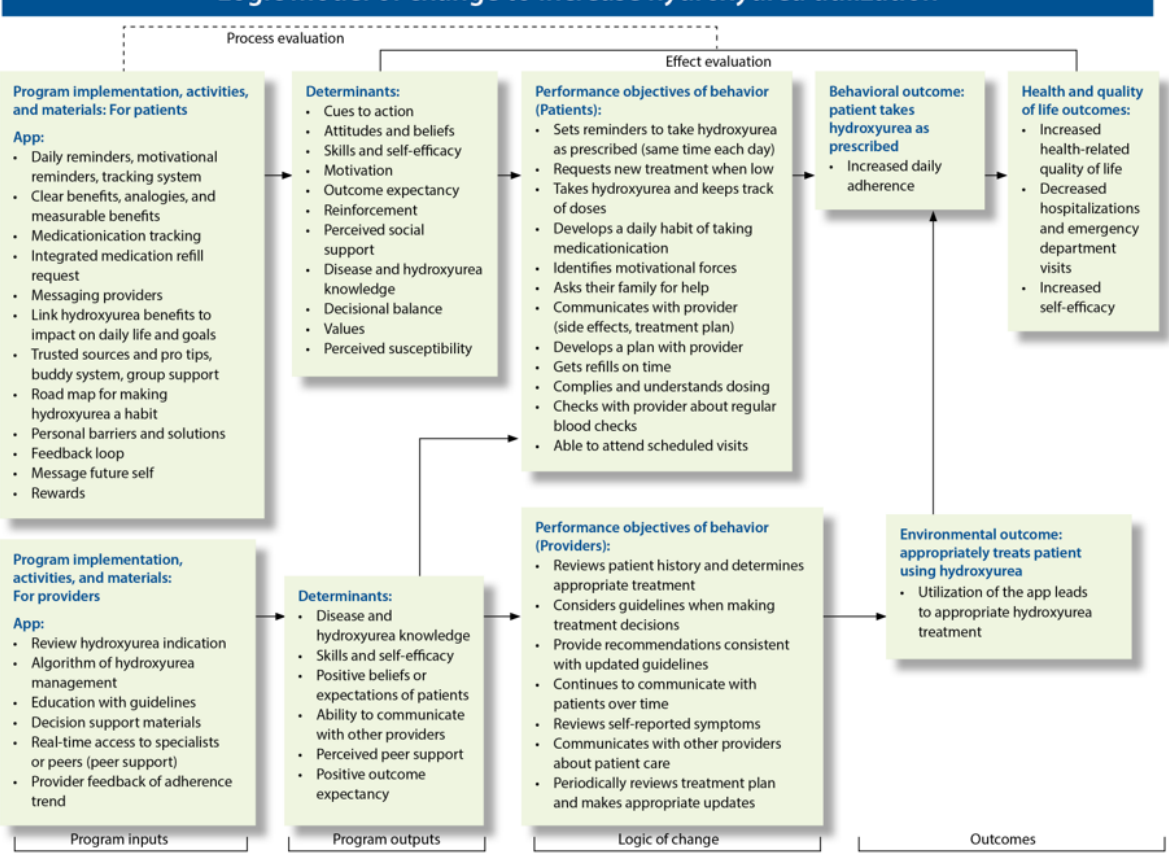
Figure 1. Logic model of change to increase hydroxyurea utilization. This logic model maps all barriers identified by literature review and needs assessment analysis, with a focus on the determinants of the behaviors to hydroxyurea use. The intervention addresses the determinants of hydroxyurea use at both the patient and provider levels. If this two-level intervention is successful, hydroxyurea utilization will increase, as reflected by